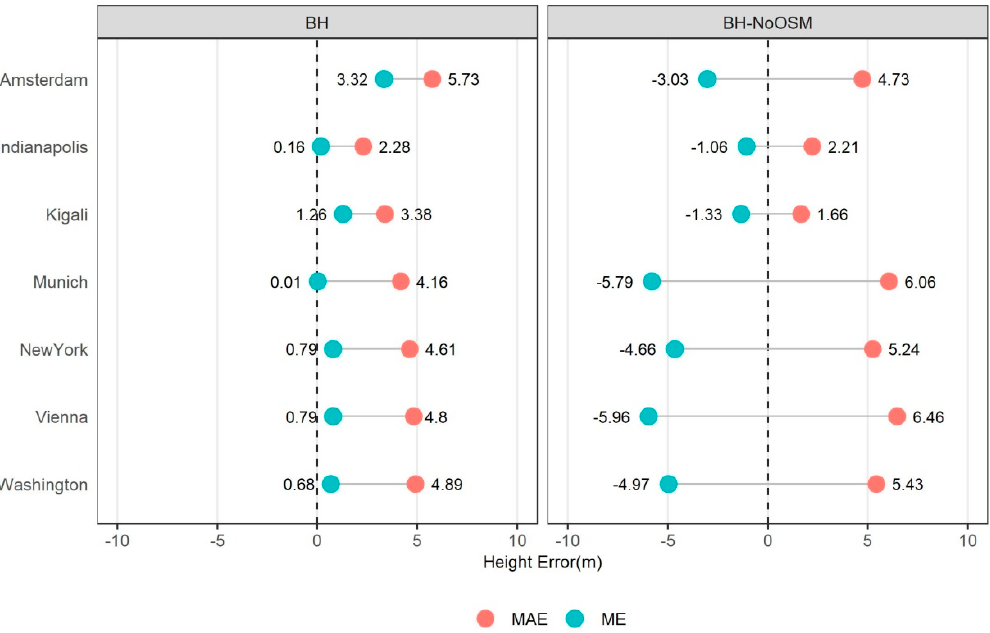
Figure 5. Mean error (ME) and mean absolute error (MAE) of building height (BH) estimation achieved for the seven study cities, given for the two cases of existing Open Street Map (OSM) data and a processing without OSM integration (BH NoOSM ).